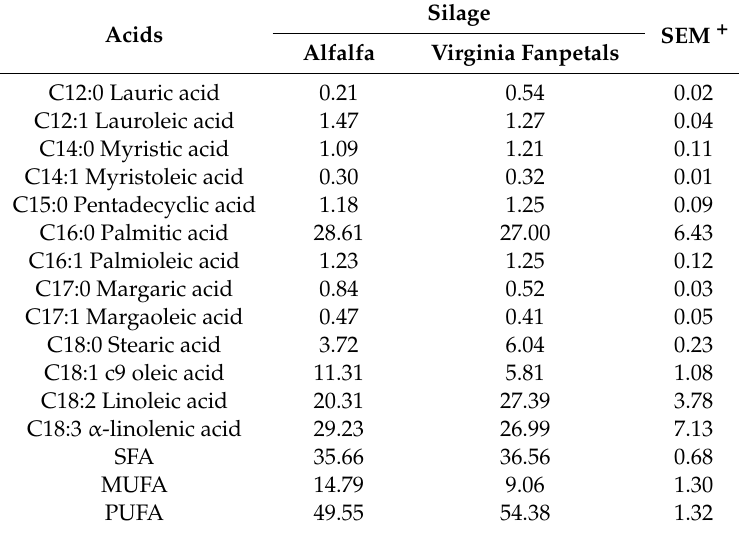
Table 3. Composition of fatty acids in the silages, expressed in g / 100 g sum of acids.